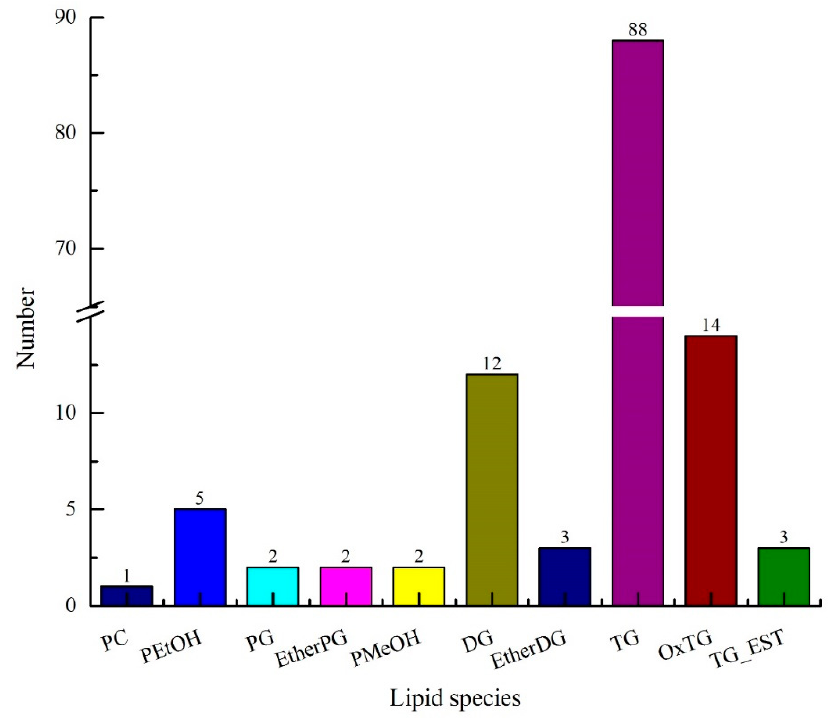
Figure 1. Lipids of composition of avocado oil.